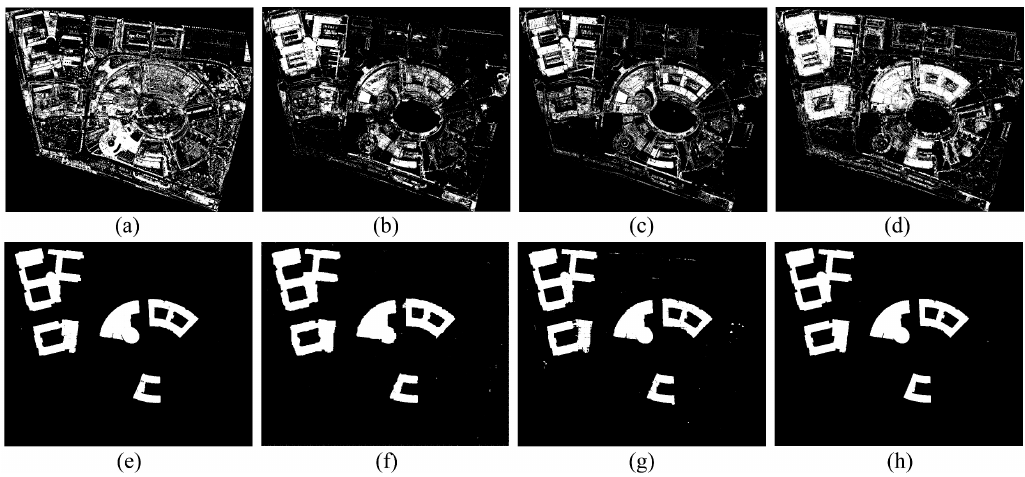
Figure 12. Binary change maps (Experiment 4) obtained by the ( a ) RCVA, ( b ) SVM, ( c ) RF, ( d ) DBN, ( e ) U-Net, ( f ) SegNet, ( g ) DeepLabv3+, and ( h ) Proposed method.